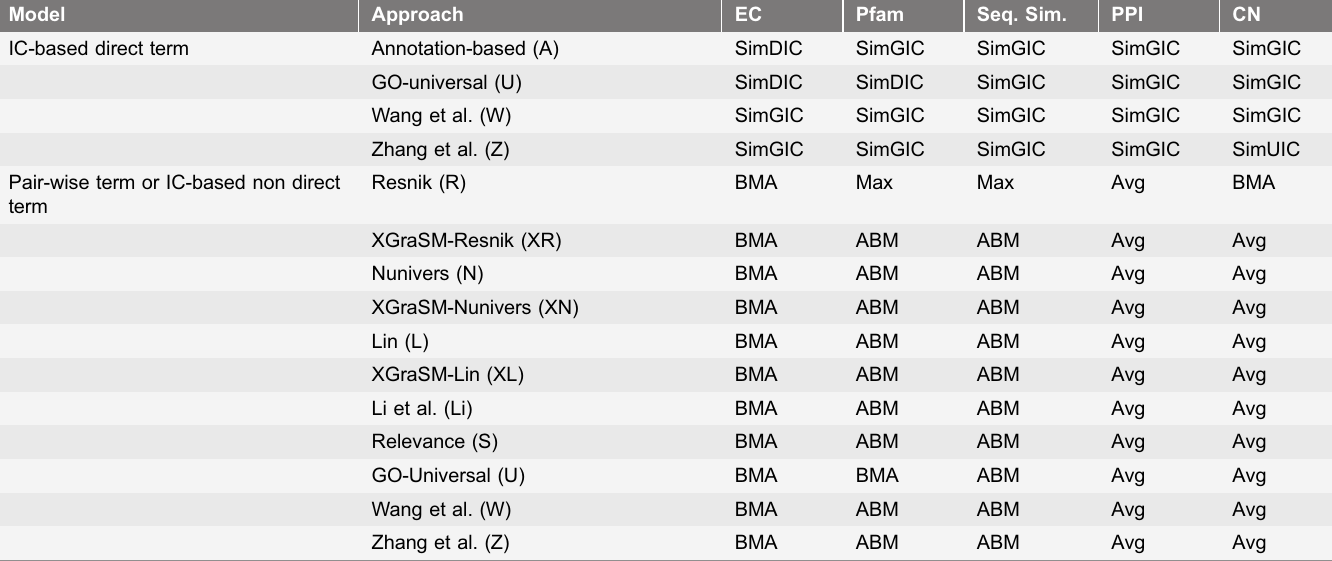
Table 5. Summary of the best performing measures for different applications.